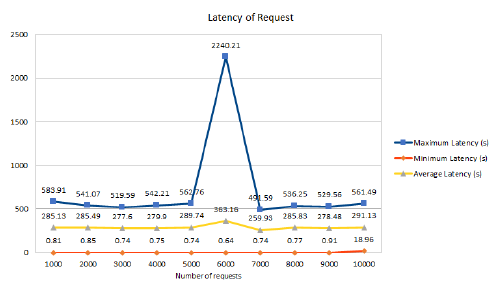
Figure 7. The latency of the data initialization functions.